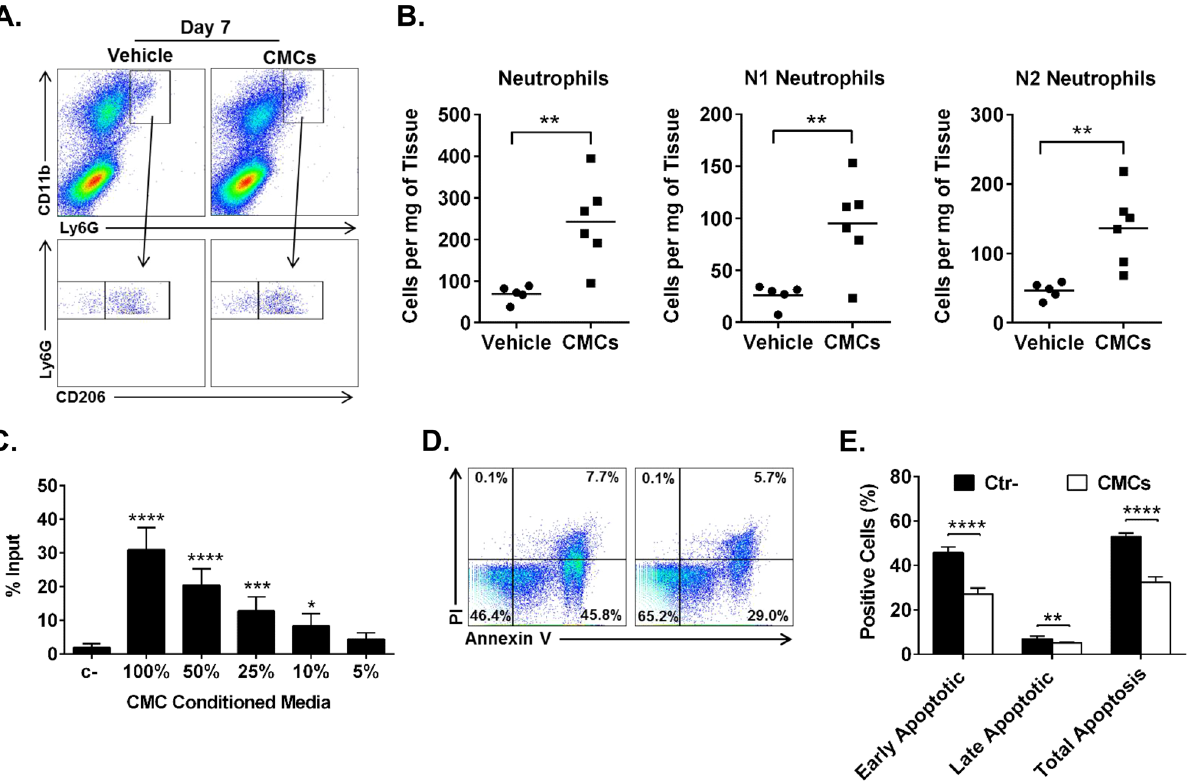
Figure 2. Effects of CMCs on neutrophils in vitro and in vivo. CMCs (5 × 10 5 ) were injected in the mouse hearts 2 d after MI. Seven days later, hearts were harvested and neutrophils were detected with flow cytometry ( A ), and quantified ( B ). Number of cells shown as mean; sham n = 5, MI = 6; ** P < 0.01 ( unpaired t test ). Bone marrow neutrophils were subjected to migration assay with modified Boyden chamber plates to CMC conditioned media. Number of migrated cells shown as mean ± SEM; n = 5; * P < 0.05; *** P < 0.001; **** P < 0.0001 ( one-way ANOVA ) ( C ). Bone marrow neutrophils were cultured in serum depleted media for 24 h in the presence or absence of CMCs conditioned media. Apoptotic cells were detected with Annexin V/PI staining ( D ) and quantified with flow cytometry ( E ). Number of apoptotic cell shown as mean ± SEM; n = 5; ** P < 0.01; **** P < 0.0001 ( multiple t test